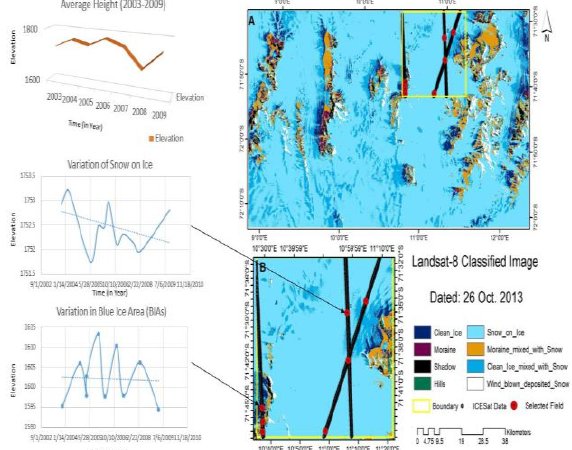
Figure 15. Ice sheet elevation changes with IceSat-1